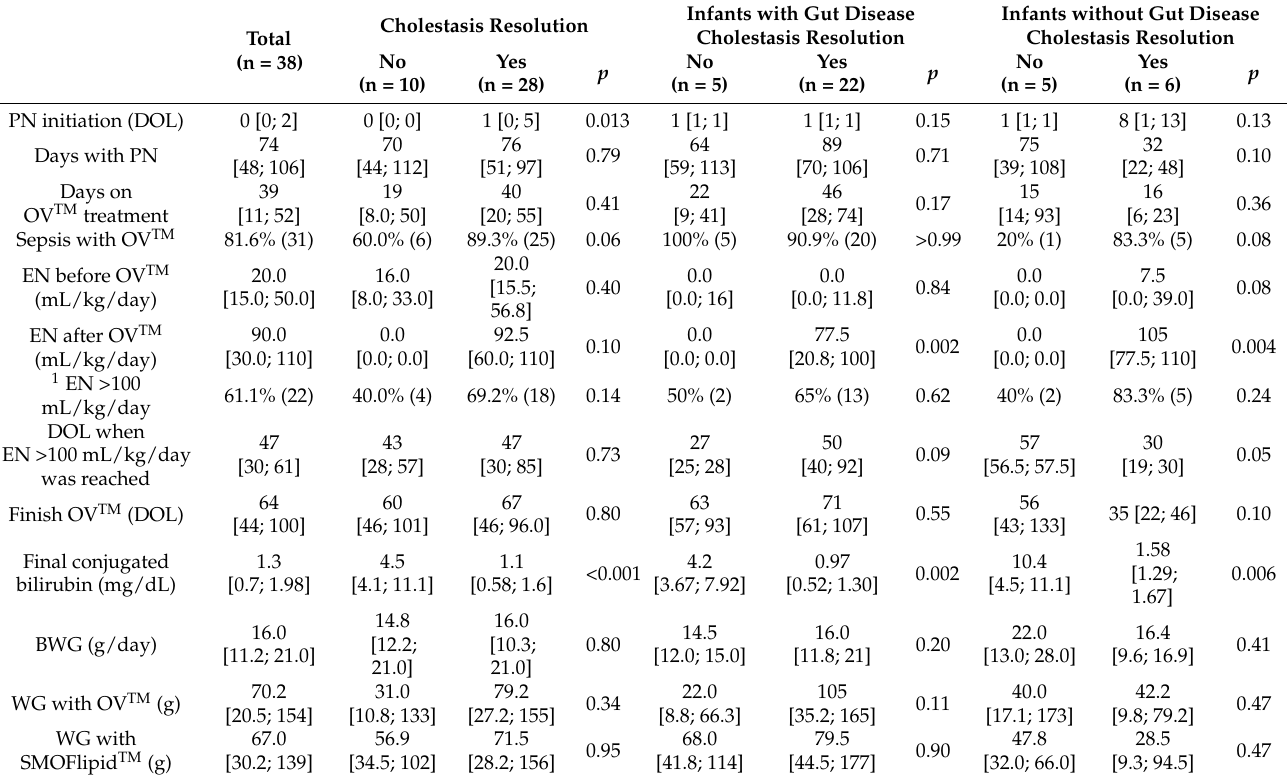
Table 2. Nutritional and ponderal body weight characteristics of the